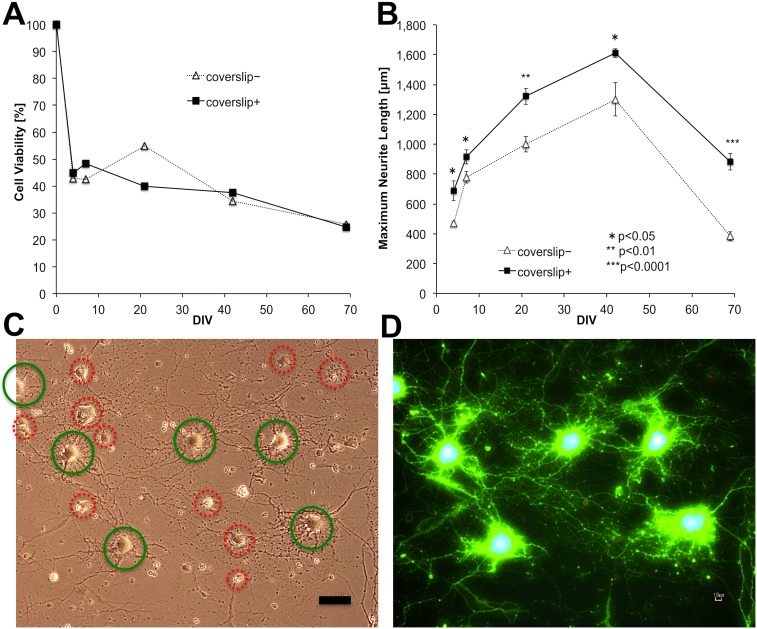
Effect of the coverslip on cell viability and maximum neurite length of primary neurons.Neurons from E18 rat hippocampi were plated on 25% PuraMatrix at 3×104 cells/mL in basic medium #0, and coverslipped 3 h after plating (+), or not (−). The neurons were plated into five multiplates simultaneously, and the cell viability and neurite length in one plate were examined only once at DIV 4, 7, 21, 42, or 69. (A) Cell viability calculated from the mean of two wells. Cell viability was evaluated by phase-contrast microscopy, and is expressed as the fraction of the living cell number 3.5 h after plating (DIV 0, 100%). Living cell numbers were counted in six areas for each well: three areas in the center and three areas at the edge of the well. There were no significant differences between coverslip (+) and (−) conditions in any of the 12 sets of data from the two wells (two-tailed Student’s t-test). (B) The maximum neurite length was expressed as the mean and standard error from the five longest neurites in each well stained with the LIVE/DEAD Viability/Cytotoxicity Kit. For each pair of coverslip (+) and (−) treatments at each DIV, significant differences are shown (one-tailed Student’s t-test). The maximum neurite length in the coverslip+ condition was significantly longer than that in the coverslip− condition throughout the culture period of DIV 4–69. (C) Phase-contrast image of coverslip+ neurons at DIV 21. Bar: 50 µm. (D) Fluorescence image of (C) stained with calcein AM (green) and ethidium homodimer-1 (red). Living cells and neurites are stained green, shown as the bright, smooth cells in C (green circles). Dead cells are stained red, shown as rough or dark cells in C (red circles). C and D show that approximately 40% of the neurons attached to PuraMatrix were alive at DIV 21 and had extended neurites and formed neuronal networks.